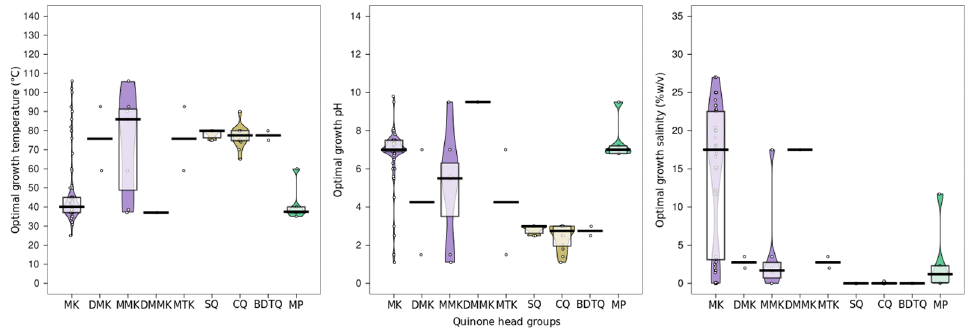
Figure 5. Correlation between optimal growth conditions and quinone head group. Menaquinone based quinones are depicted in purple (MK, DMK, MMK, DMMK, MTK), Sulfolobusquinone based quinones in yellow (SQ, CQ, BDTQ) and Methanophenazine (MP) in green. See the phylogenetic tree for head group structure. Abbreviations: MK, Menaquinones; DMK, Demethylmenaquinones; MMK, Monomethylmenaquinones; DMMK, Dimethylmenaquinones; MTK, Methionaquinones; SQ, Sulfolobusquinones; CQ, Caldariellaquinones; BDTQ, Benzodithiophenoquinones.